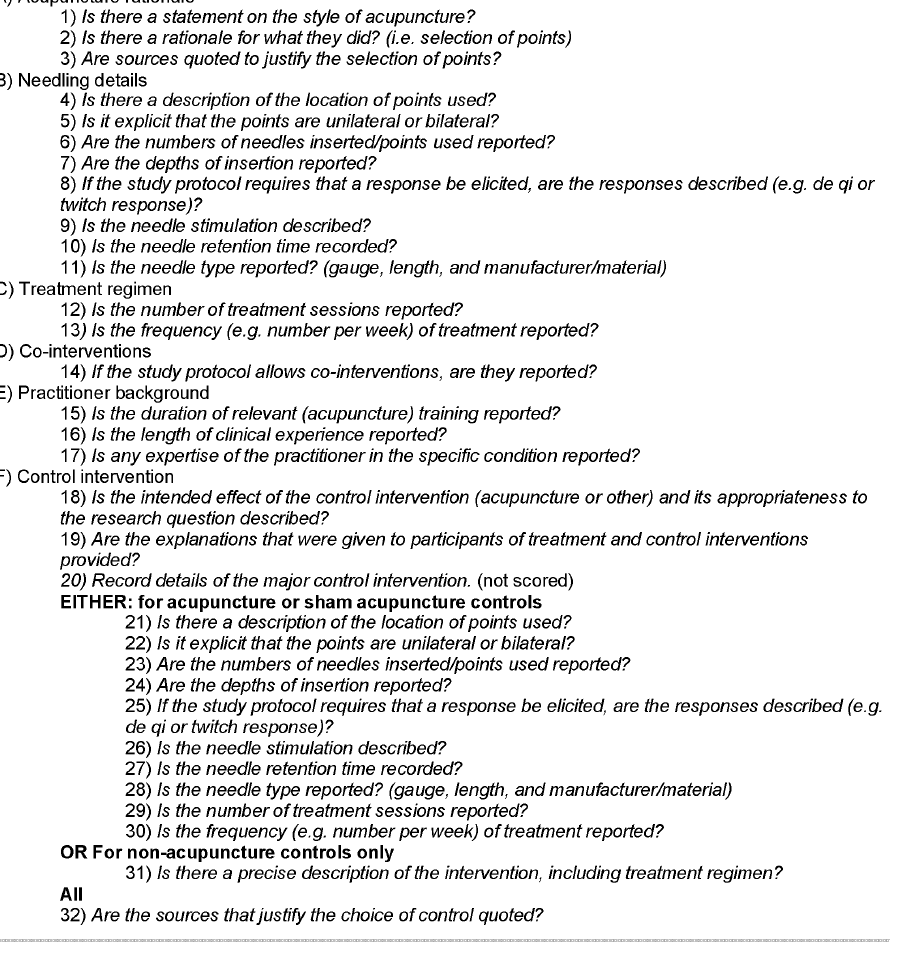
Figure 2. STRICTA checklist used to evaluate studies.